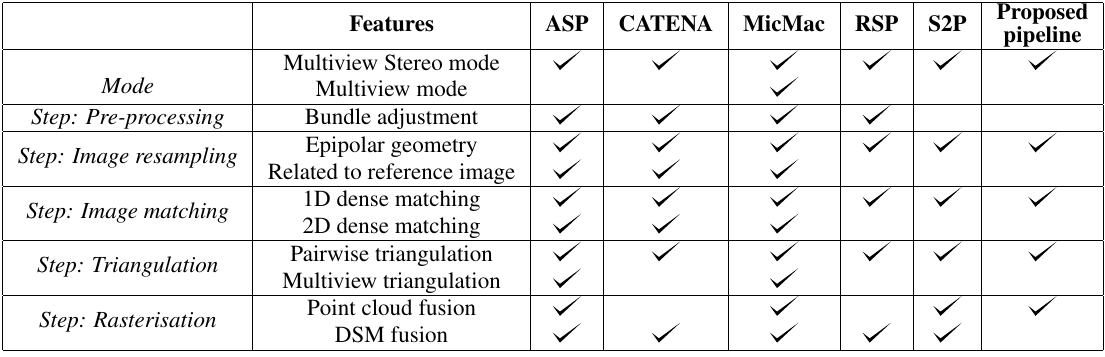
Table 1. Features comparison for existing stereo pipelines, established by reading reference papers and software